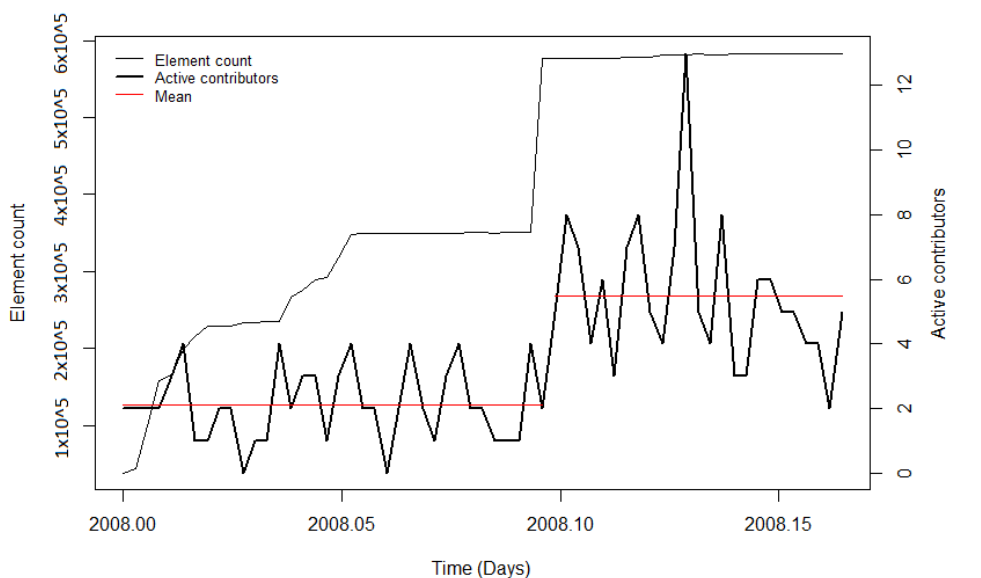
Figure 6. Contributor activity during the AND import in